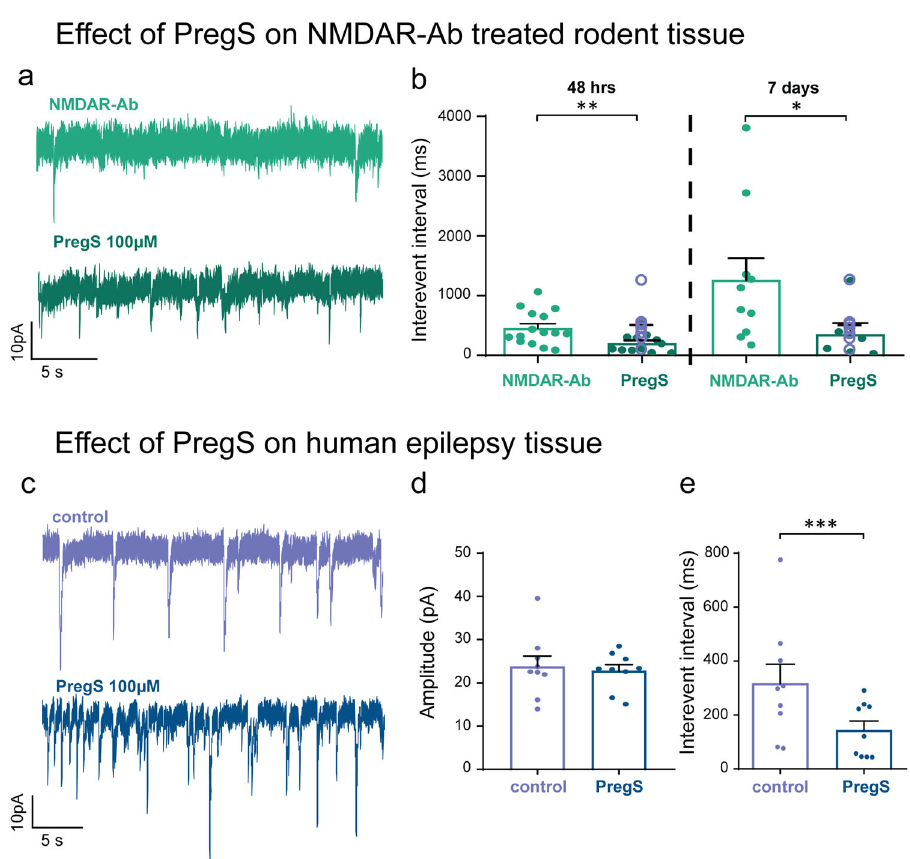
Fig. 7 Pregnenolone sulphate increases glutamatergic transmission in NMDAR antibody infused rodent hippocampal slices in vitro and has similar effects in human epilepsy brain tissue. a Representative whole-cell patch clamp recording of putative CA3 pyramidal cell sEPSCs from an NMDAR antibody treated hippocampal slice before and after addition of PregS. Scale bar 10 pA vs. 5 s. b IEI of sEPSCS recorded from putative CA3 pyramidal cells before and after PregS application to hippocampal slices prepared from NMDAR antibody treated animals at 48 h after Ab injection ( n = 12 pairs of